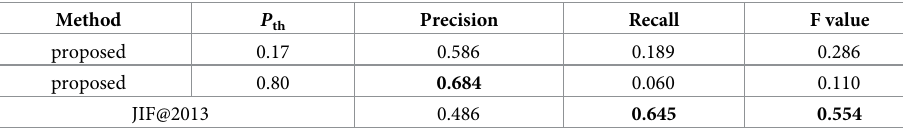
Table 12. Results of future JIF